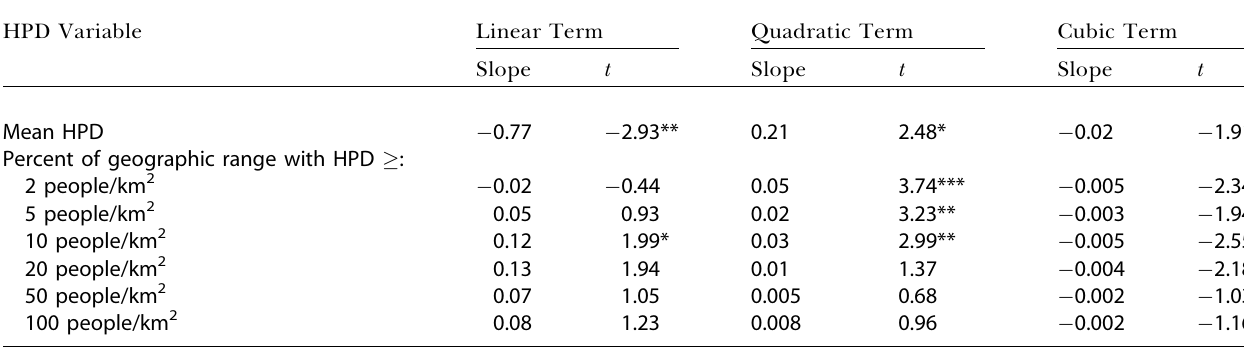
Table 1. Regressions of Extinction Risk against HPD Using Phylogenetically Independent Contrasts HPD Variable Linear Term Quadratic Term Cubic